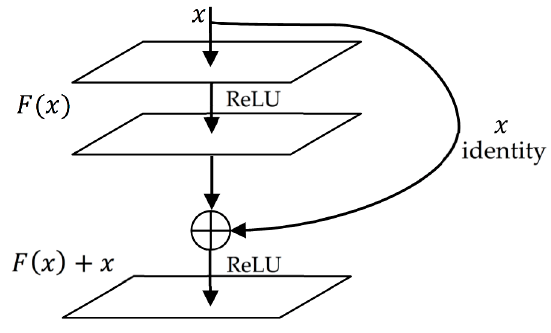
Figure 5. Residual connection.